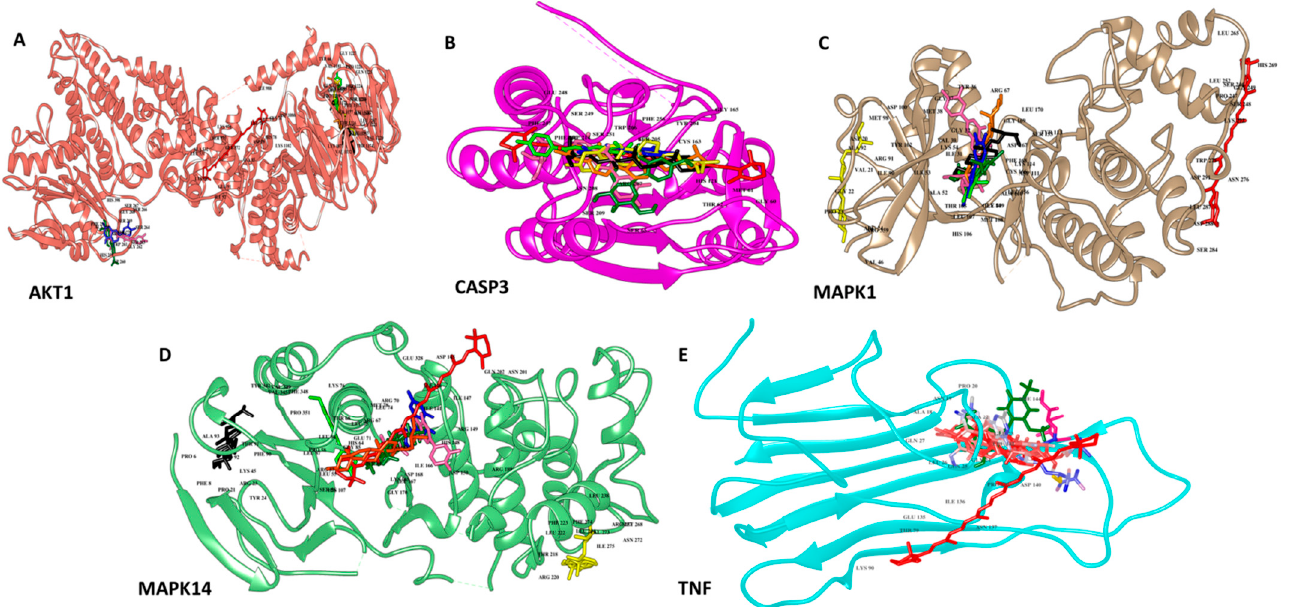
Figure 10. The docking complex of five targets with their best binding components shows the binding site residues with the protein. ( A ) AKT1; ( B ) CASP3; ( C ) MAPK1; ( D ) MAPK14; ( E ) TNF.